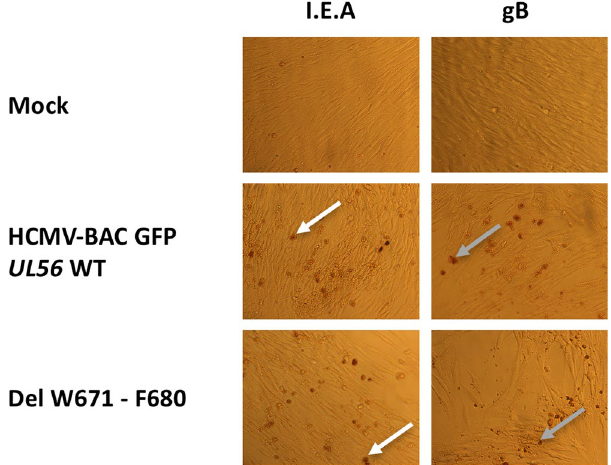
Figure 3. Fragment 671 WMVVKYMGFF 680 of pUL56 is not required for viral gene expression. MRC-5 were transfected with HCMV-BAC WT or the mutant with a deletion of 671 WMVVKYMGFF 680 sequence. Five days after transfection, immunostaining was performed for immediate early (I.E.A) (white arrow) and late (gB) (grey arrow) viral proteins.